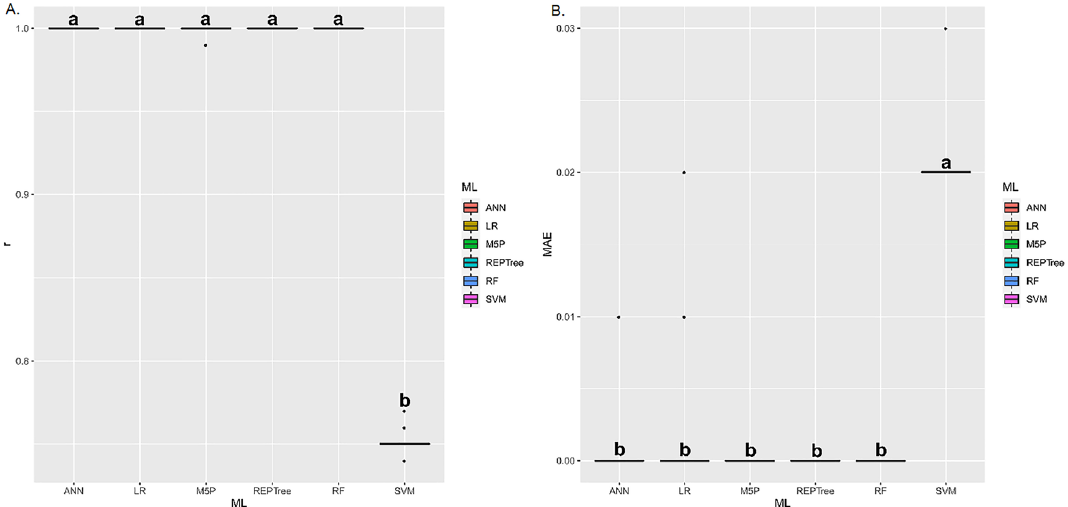
Figure 11. ( A ) Boxplot for Pearson correlation coefficient (r), and ( B ) mean absolute error (MAE) between observed and estimated values of loss of dry matter in corn grains by different machine learning models and inputs. Means followed by equal letters in the same column do not differ by the Scott-Knott test at 5%